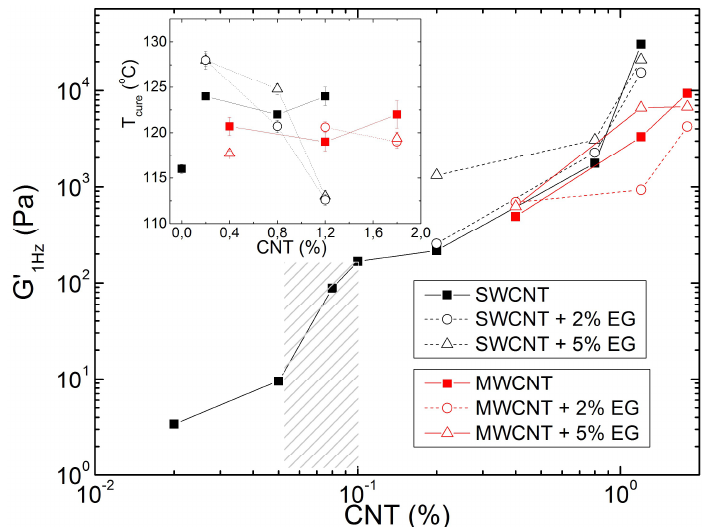
Figure 8. Evolution of the storage modulus measured at 1 Hz (G 1Hz ) as a function of the carbon nanotube content in the resin. The dashed area represents the onset of SWCNT percolation in the resin. Solid symbols correspond to resins containing only carbon nanotubes (SWCNT or MWCNT), whereas empty symbols refer to data measured for mixed systems where 2 wt.% (circles) and 5 wt.% (triangles) were added to the resin with carbon nanotubes. Inset: temperature for onset of curing as a function of the carbon nanotube content. Symbols are as in the main chart.